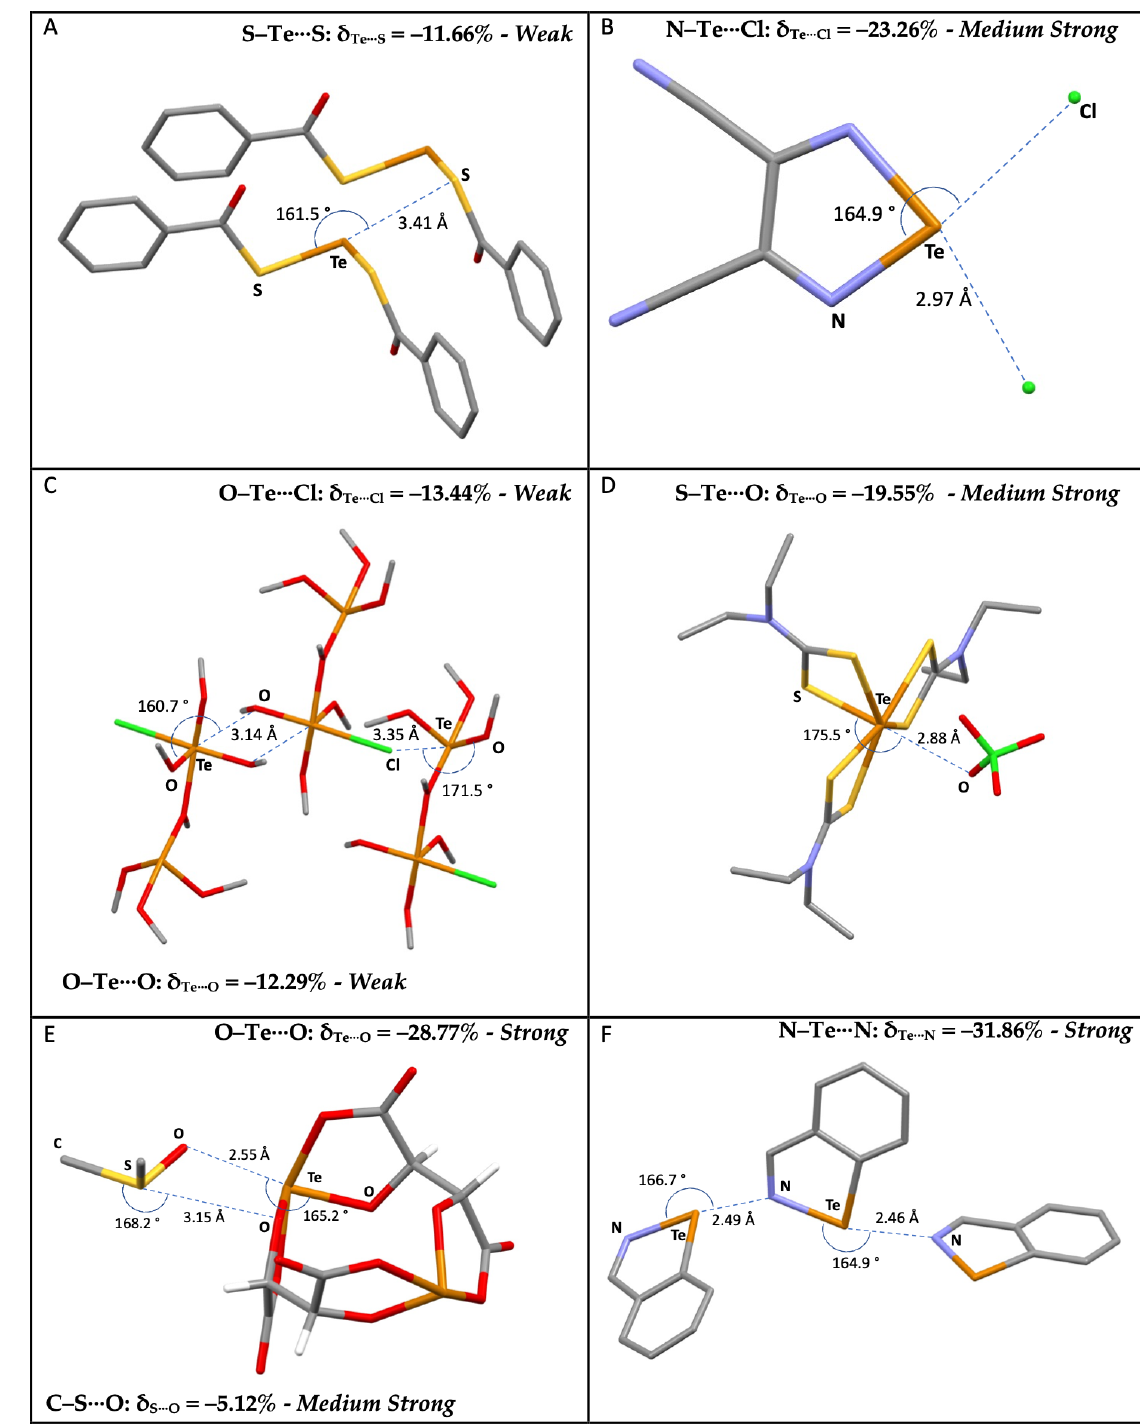
Figure 8. Examples of selected R–Te · · · A fragments featuring ChBs and corresponding CCDC refcodes: ( A ) CISPUP; ( B ) GESSAC; ( C ) QAYVAN; ( D ) JAWPOM; ( E ) NIVRAM; ( F ) BZITEZ. MW: medium-weak; MS: medium-strong; S: strong. Atom colors: C (gray); N (blue); Oxygen (red); S (yellow); Te (orange); I (purple); Cl (green); F (acid